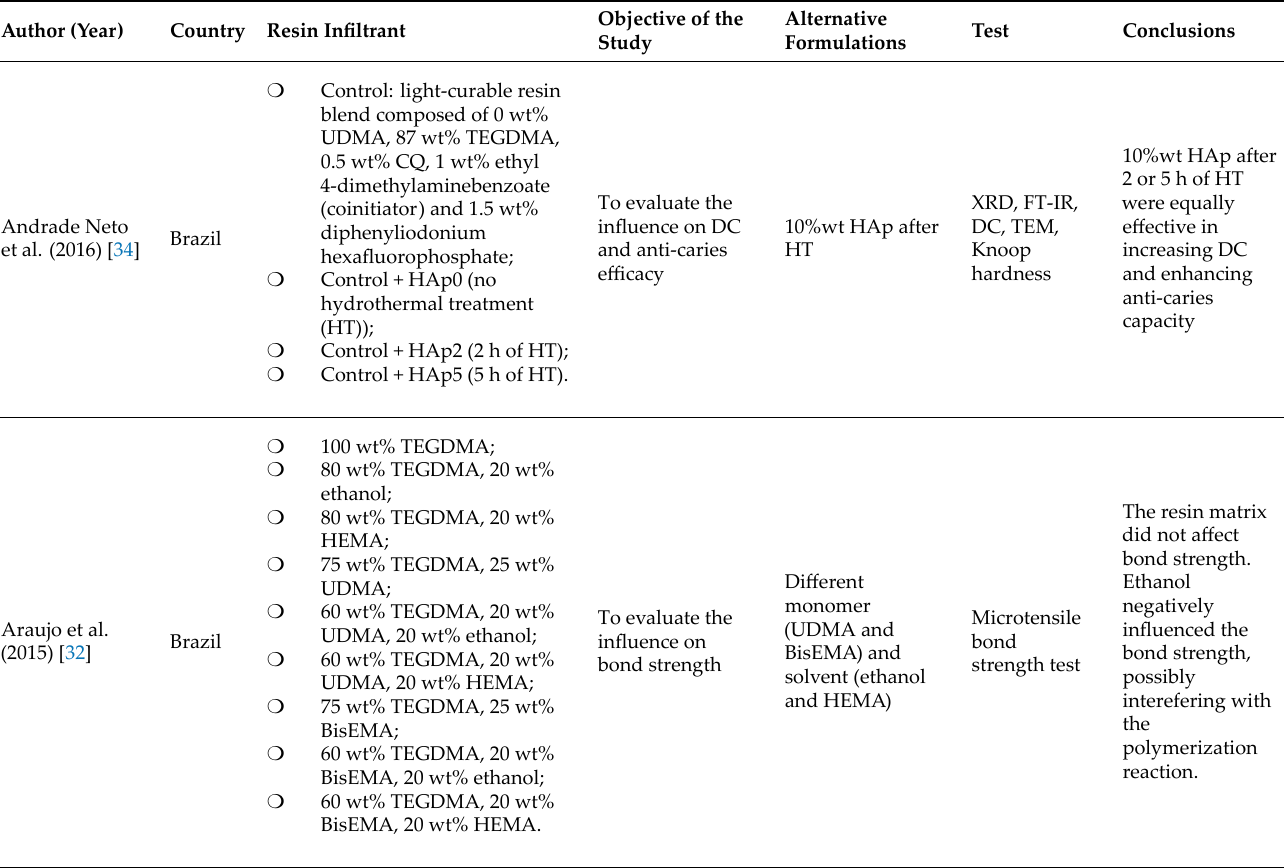
Table 1. Data retrieved from the review analysis. TEGDMA: triethylene glycol